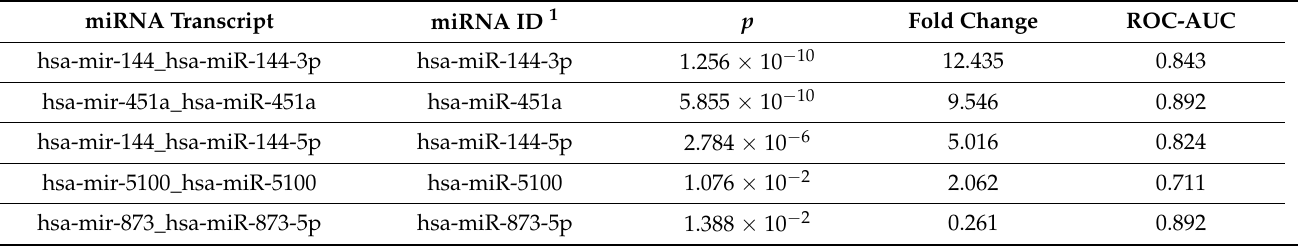
Table 3. MiRNA transcripts found to be differentially expressed in PBMCs of LEAD patients diag- nosed with Rutherford category 3 compared to LEAD patients with Rutherford category 2. The table presents the miRNAs resulted from the DESeq2 analysis with Benjamini-Hochberg FDR < 0.05.